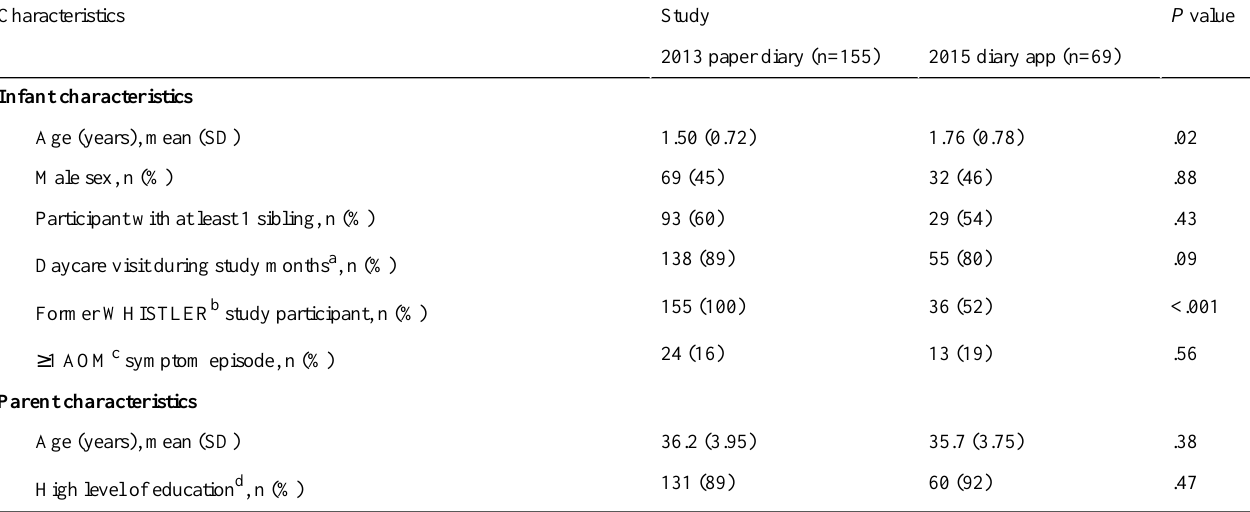
Table 1. Baseline characteristics of the 2013 and 2015 study populations.